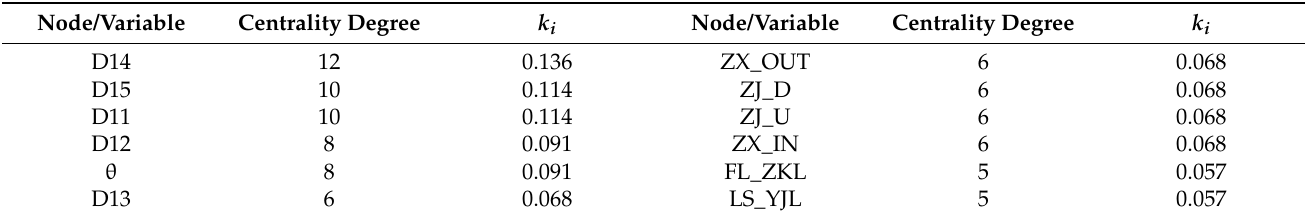
Table 3. Importance index of key variables.